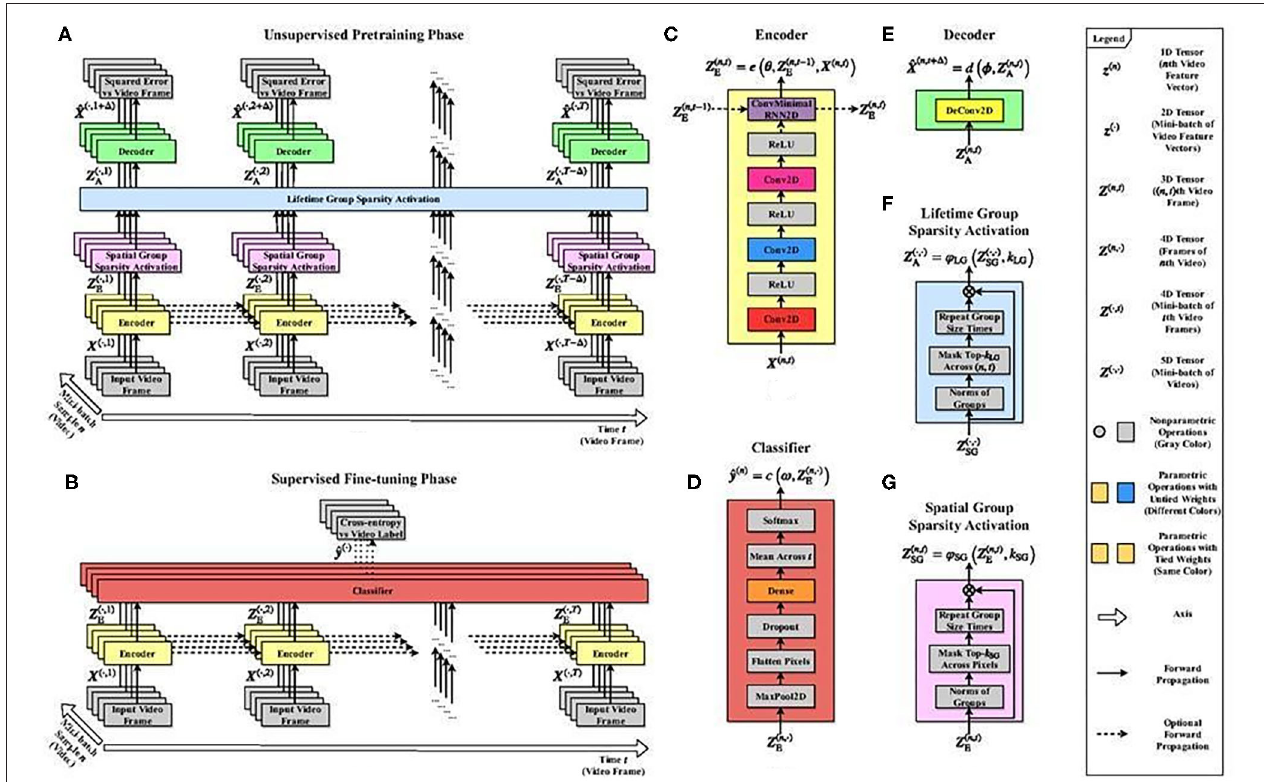
FIGURE 6 | Illustrative predictive structured sparse architecture that models columnar organization. Schematic diagram of a neural network architecture with (i) many layers, (ii) recurrent extension of (iii) structured sparsity for modeling columnar organization. The architecture that reaches state-of-the-art performance (29, 30) illustrates architectural complexity for modeling a few of the autoencoding aspects of autism. Unmodeled features include, e.g., (iv) delay compensation, (v) different modalities, (vi) information fusion, (vii) synchronization between modalities, and (viii) the selection of a single percept. The number of parameters is still very large and offers too much freedom for modeling, while real data is uncertain. For example, autism-like features could be produced when modeling the contradictory findings on the distance and thus the speed and strength of interaction between minicolumns ( 31, 32). “Spatial group sparsity” sparsifies representation. “Lifetime group sparsity” keeps all units to play a role during the learning phases. Notation: subscripts E, A, SG, and LG denote encoding, activation, spatial group sparsity, and lifetime group sparsity, respectively. For more details, see legend. Details of the architecture: (A) The overall architecture is a deep convolutional neural network that takes N videos of T- 1 frames as input and generates the video frame approximations forward in time in unsupervised pre-training phase. (B) In supervised fine-tuning phase, the videos are mapped to the video labels. (C) The encoder e is a deep, recurrent convolutional neural network that takes the input and produces the encoding, i.e., the hidden representation. (D) The classifier c is a dense neural network that takes the encoded hidden representations as input and computes the video class label approximation. (E) The decoder d is a single linear deconvolutional layer that takes the group sparse hidden representation as input and returns the video frame approximation. (F) The lifetime group sparsity activation function takes the spatial group sparse hidden representations as input and yields the lifetime group sparse hidden representations by keeping the feature map groups across sample indices and replacing the rest with zero. (G) The spatial group sparsity activation function takes the encoded hidden representation as input and calculates the spatial group sparse hidden representation by keeping the feature map groups across pixel indices and replacing the rest with